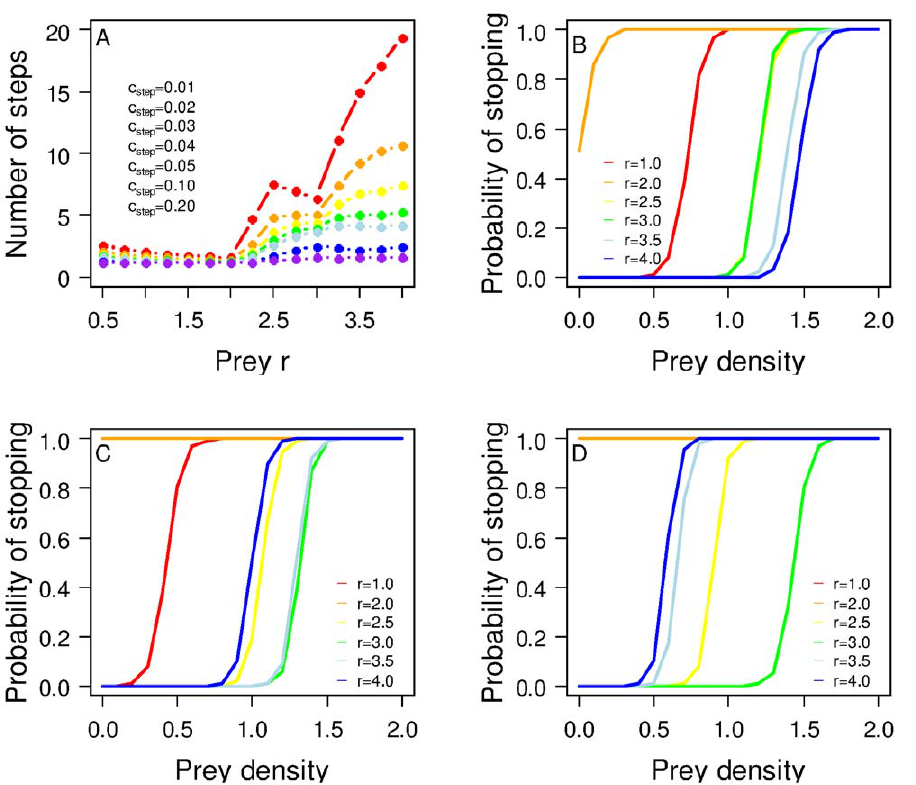
Figure 3. Predators are choosier and take more steps when the per-step cost of dispersal is low. Here we illustrate results obtained when the predators evolve a stopping rule that is sensitive to the ratio of prey per predator. The mean number of steps taken by predators is shown for a range of prey r and per-step mortality c step in A. In B, C and D, we show the mean stopping rules that evolve for c step =0.02, 0.04 and 0.10, respectively.